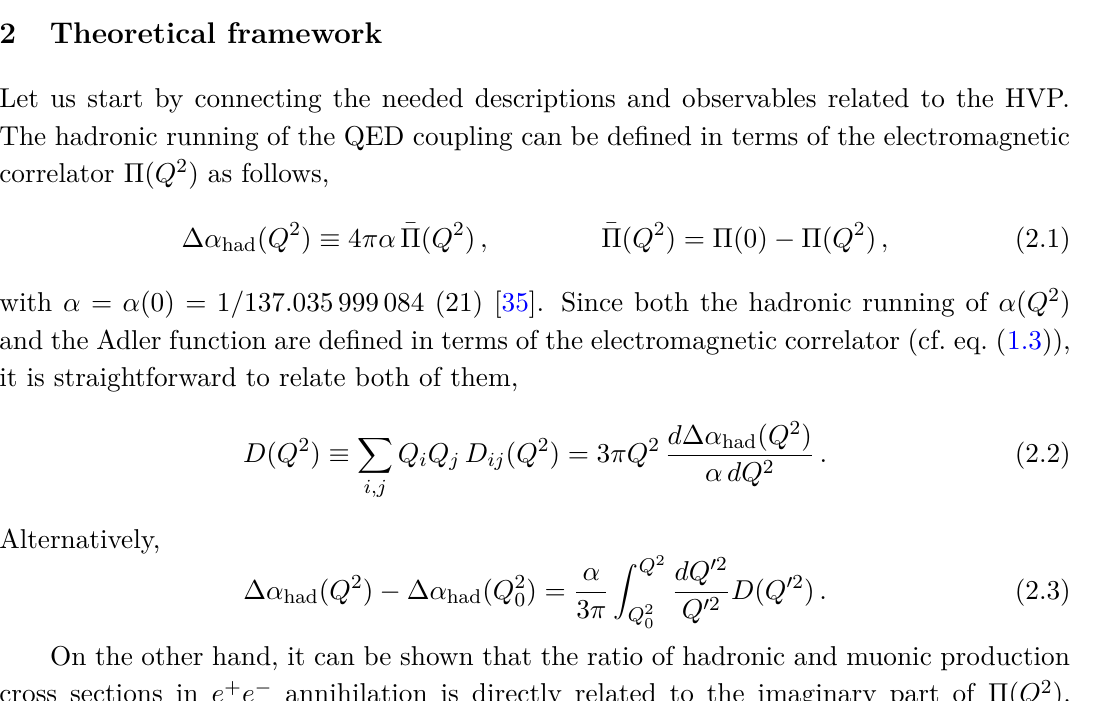
W ( Q 2 ; Q 2 , Q 2 ) · Π ij ( Q 2 ) in the q 2 = − Q 2 complex 1 2 2 πi